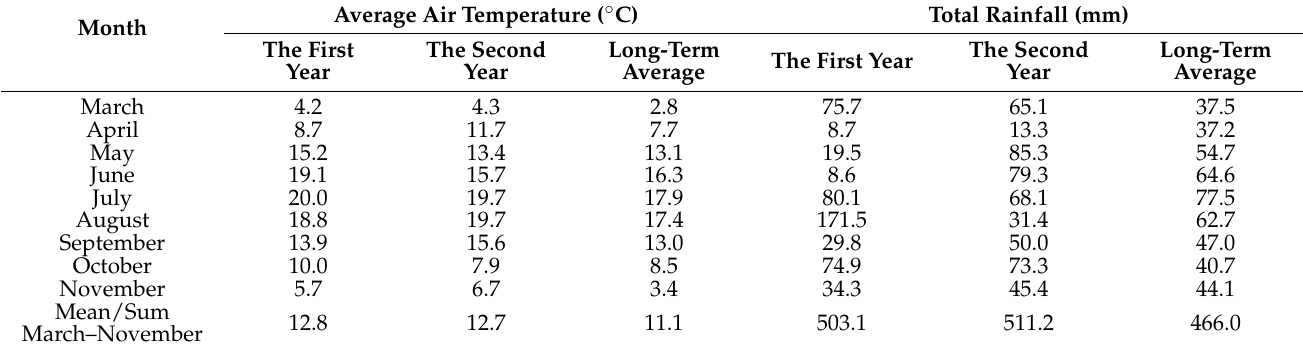
Table 1. Weather conditions during the vegetation period in RGD Brody in the years of